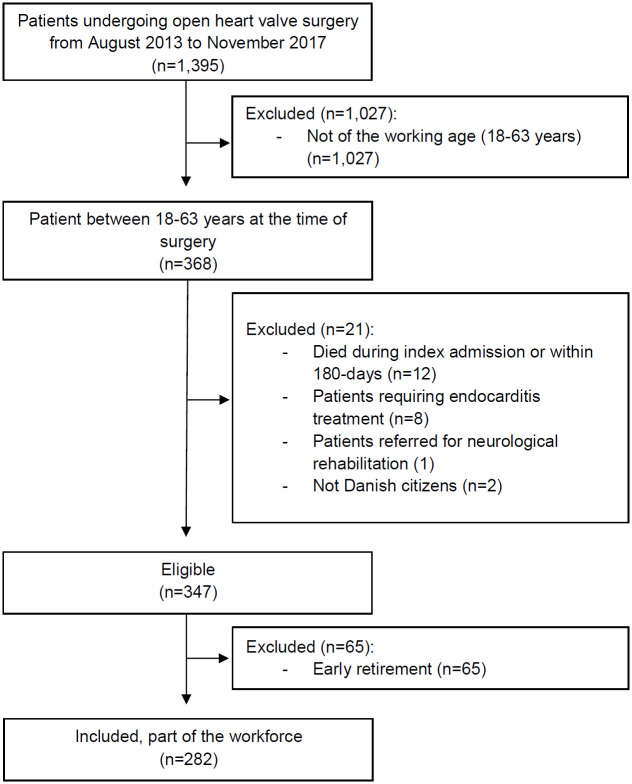
Patient flowchart.Flowchart of the patient population.